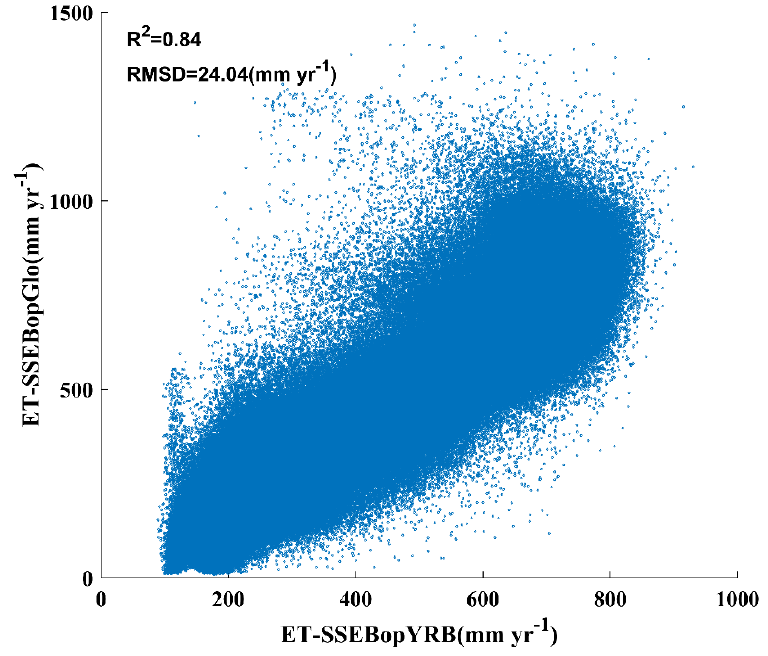
Figure A13. Pixel-based average annual ET comparison between ET SSEBopYRB and ET SSEBopGlo in YRB during the years 2003–2015. RMSD is the root mean square difference (RMS ETSSEBopGlo – RMS ETSSEBopYRB ).